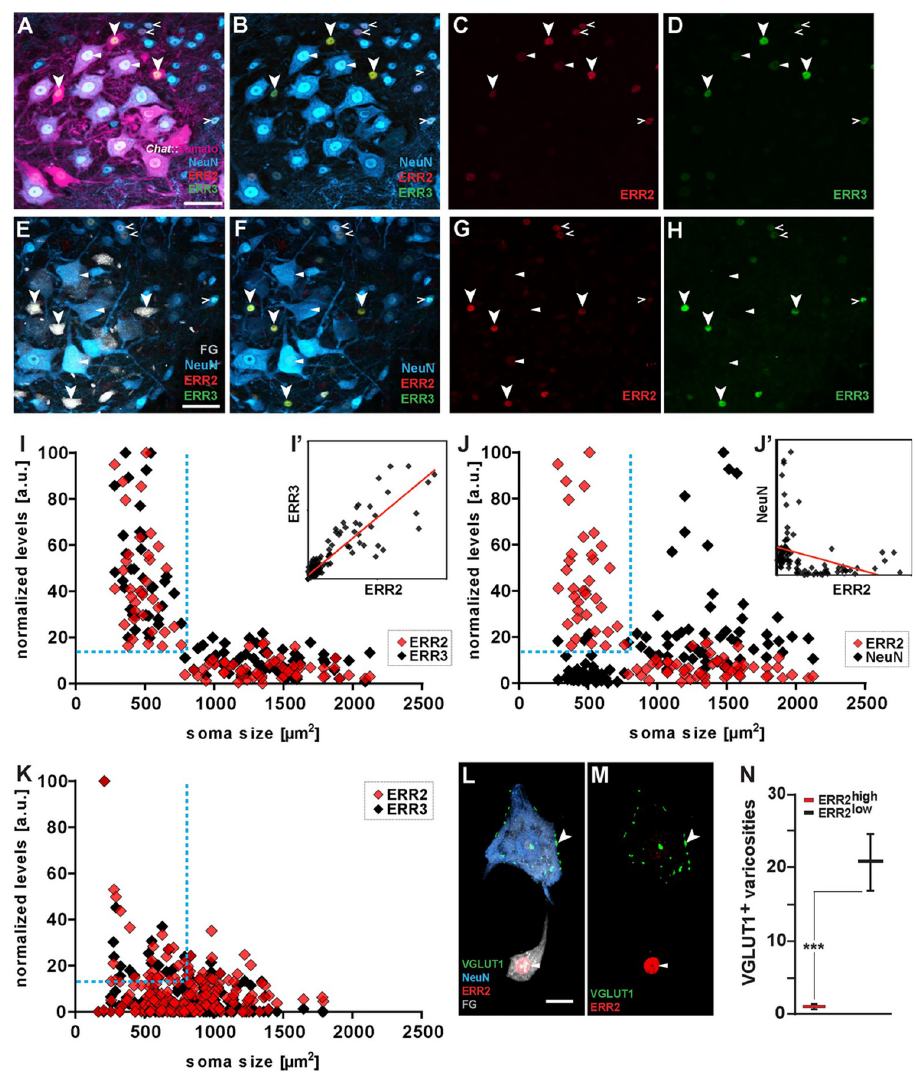
Fig 2. High levels of correlated ERR2/3 expression by gamma motor neurons. (A-D) Transversal section of P21 Chat Cre ; Rosa26 floxtdTomato mouse lumbar spinal cord ventral horn: motor neurons genetically labeled by tdTomato (scale bar: 50 μ m). Arrowheads: high ERR2 and ERR3 levels in small NeuN low , tdTomato + motor neuron nuclei. Open arrowheads: relatively moderate-to-high levels ERR2/3 levels in NeuN high tdTomato − interneurons. Triangles: consistently lower but detectable levels in some large motor neurons with moderate-to-high NeuN levels. (E-H) . Transversal section of P21 (wild-type) mouse lumbar spinal cord ventral horn: motor neurons labeled by retrograde tracer Fluoro-Gold (FG) (scale bar: 50 μ m). Arrowheads: high ERR2 and ERR3 levels in small NeuN low that retain high levels of FG high . Open arrowheads: relatively moderate-to-high levels ERR2/3 levels in NeuN high FG − interneurons. Triangles: consistently lower but detectable levels in some large motor neurons with moderate-to-high NeuN levels. (I) Quantitative analysis: high ERR2 (red) and ERR3 (green) levels in motor neurons with small somas. (I’) L Linear regression: strong positive correlation of motor neuron Err2 and Err3 levels. ( F ) High Err2 (red) and NeuN (black) levels in nonoverlapping motor neuron populations ( n = 93, N = 3, Pearson’s correlation coefficient r = 0.86). (J) High ERR2 (red) and low NeuN (blue) levels in motor neurons with small somas. (J’) Linear regression: lack of positive correlation between Err2 and NeuN levels in motor neurons ( n = 93, N = 3, Pearson’s correlation coefficient r = − 0.32). (K) Loss of high ERR2 (red) and ERR3 (green) levels by Egr3-deficient small motor neurons ( n = 184, N = 3). ( L-N) Imaris 3D reconstruction: VGLUT1 + synaptic varicosities associated with ERR2 low NeuN high motor neuron, but not with adjacent ERR2 high NeuN low motor neuron ERR2 low motor neuron (motor neurons retrogradely labeled by FG) (scale bar: 20 μ m). ( N) Quantification of VGLUT1 + synaptic varicosities associated with ERR2 high or ERR2 low motor neurons. N = # of mice and n = # of neurons. Statistically significant differences between motor neurons are indicated as: � p < 0.05, �� p < 0.01, ��� p < 0.001, n.s. = not significant, Student t test). Data for Fig 2I, 2J, 2K, and 2N can be found in S2